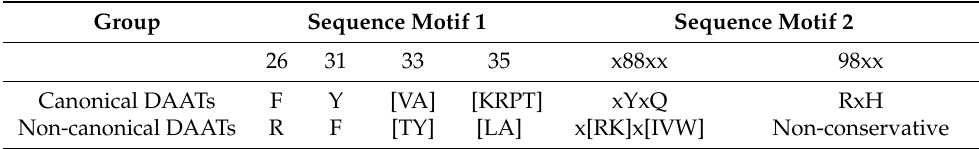
Table 2. The specificity-determining motifs of two groups of DAATs. Numeration as in bsDAAT (PDB ID 1DAA).